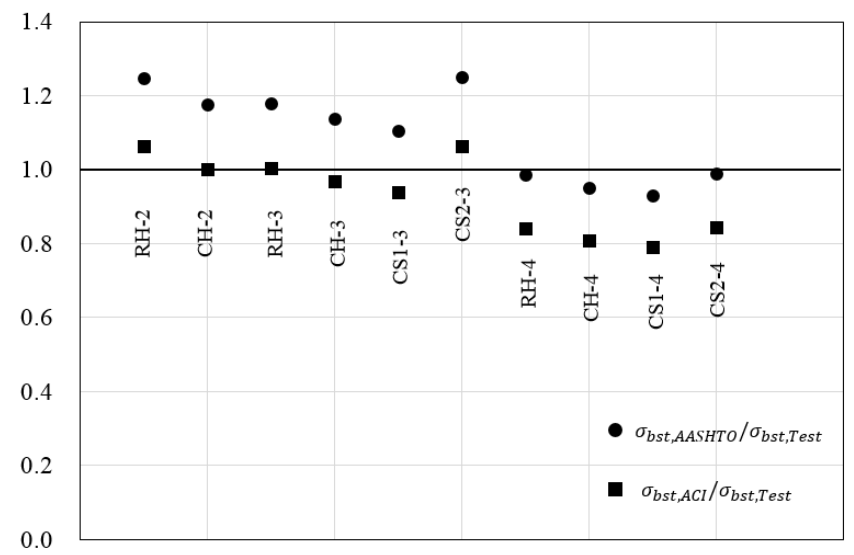
Figure 9. Comparison of bursting stresses from design code and test results.